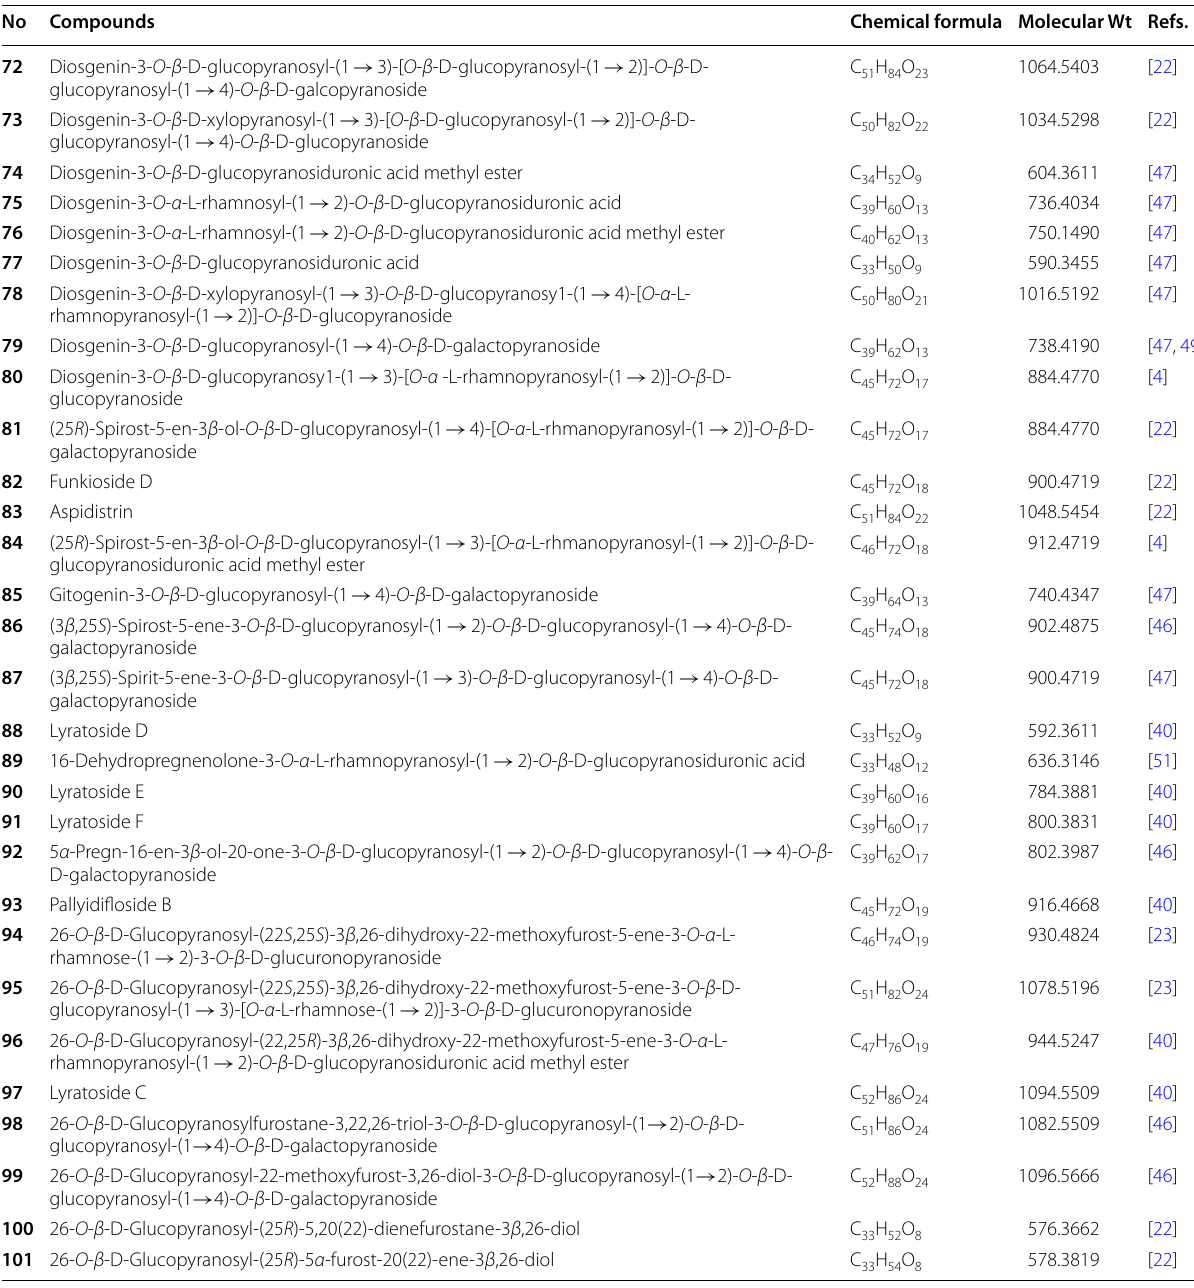
Table 5 Steroidal saponins isolated from S. lyratum No Compounds Chemical formula Molecular Wt